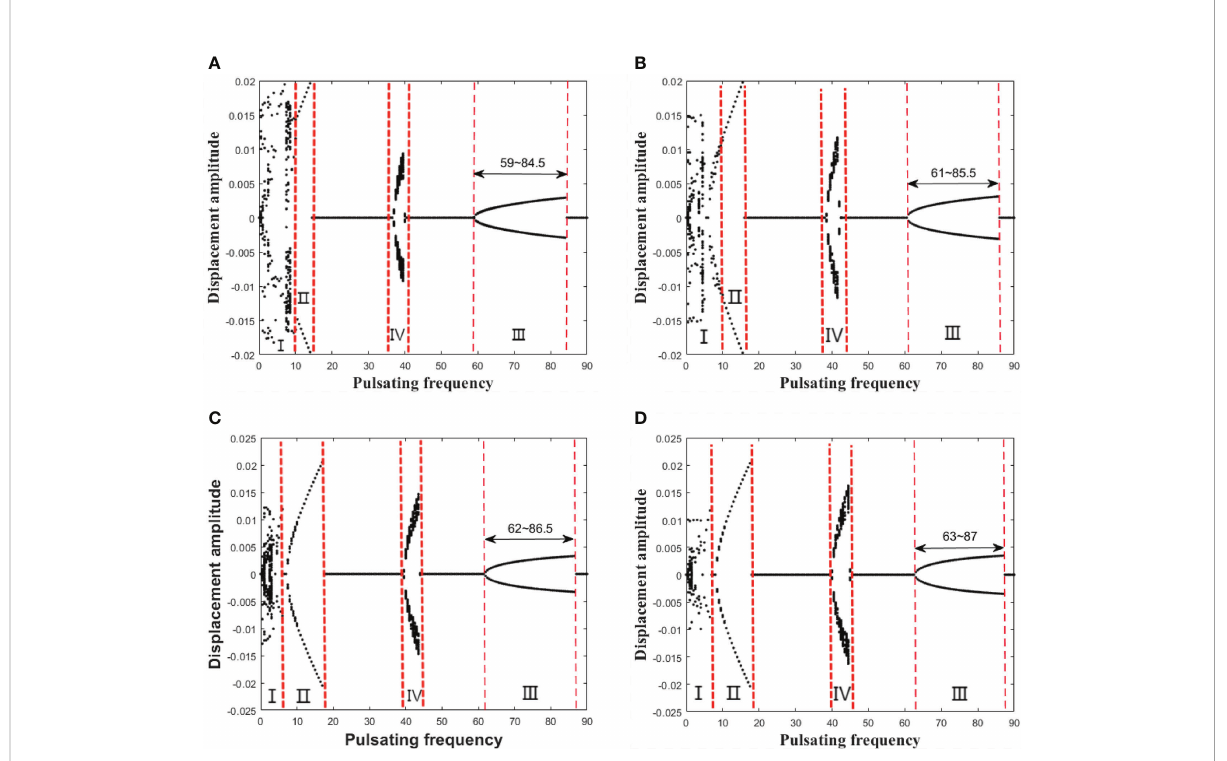
FIGURE 15 The bifurcation diagram for the midpoint of the pipe with axially added mass coef fi cient b (in which u = 2, υ = 2, m = 0.6, and the control parameter is the pulsating frequency w p ). (A) b = 0.01; (B) b = 0.03; (C) b = 0.05; (D) b =